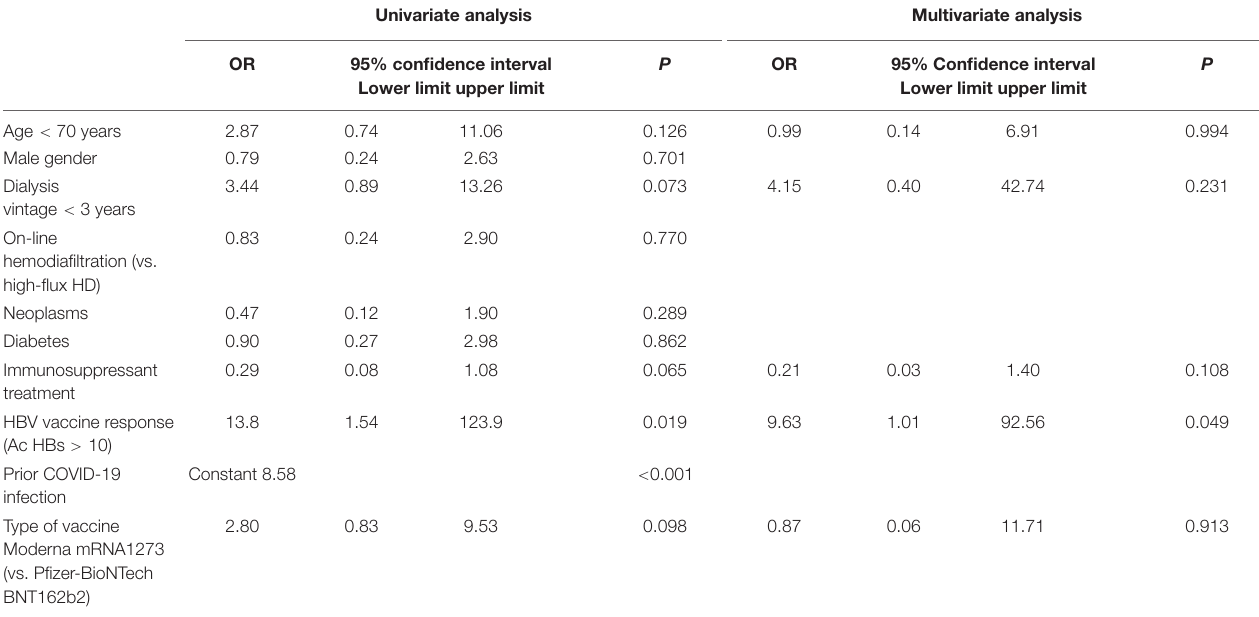
TABLE 4 | Univariate and multivariate logistic regression for predicting sustained effective humoral response (SARS-CoV-2 anti-S-RBD antibody levels > 1,000 AU/ml) 4 months after the third mRNA booster dose. Univariate analysis Multivariate